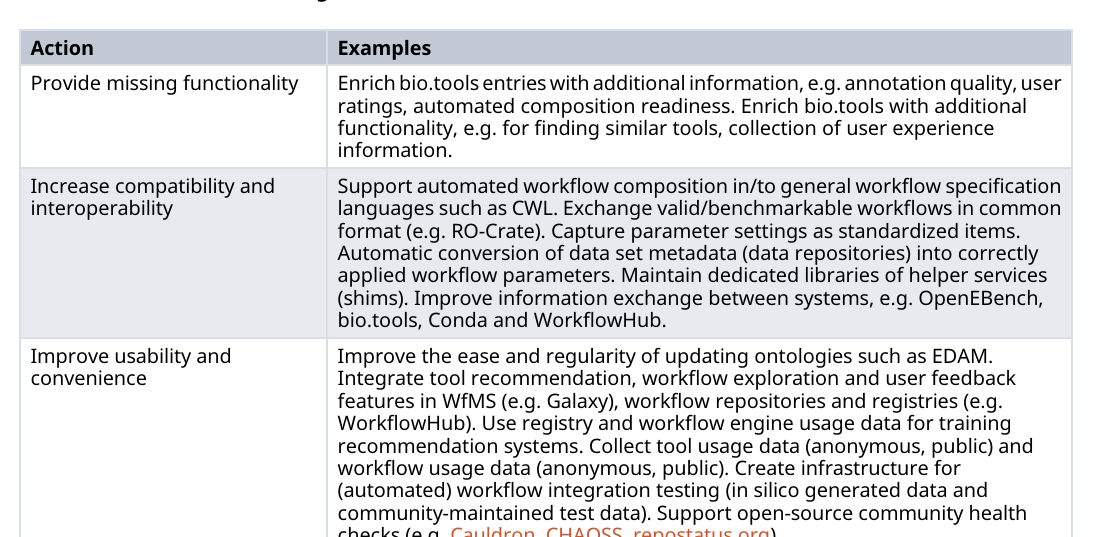
Table 3. Future work on tooling and infrastructure.